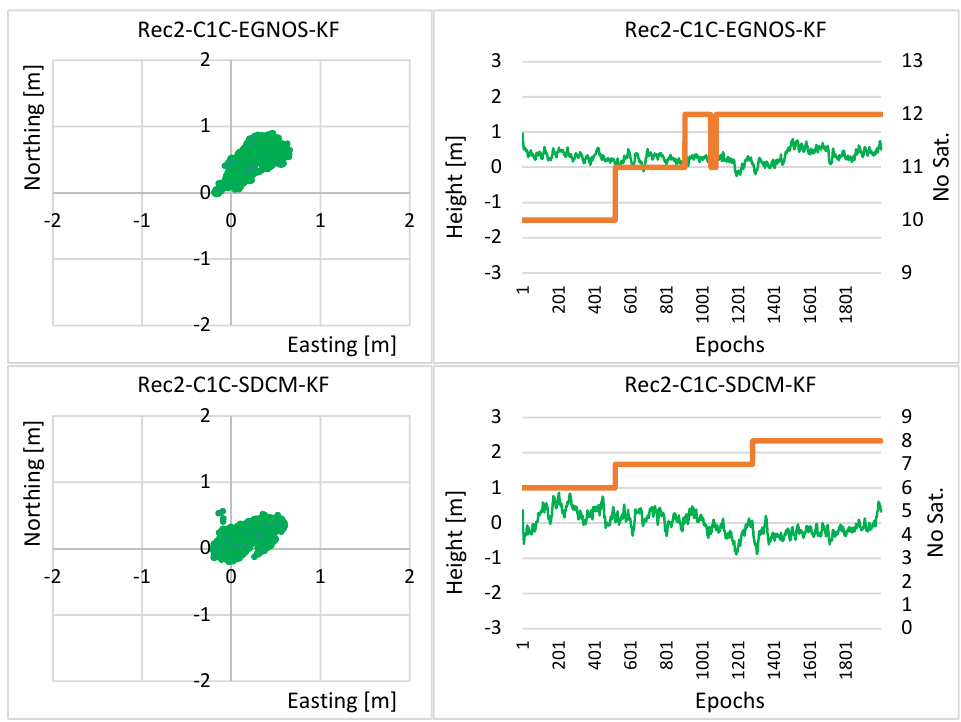
Figure 10. Real errors of horizontal and vertical coordinates of SBAS positioning based on C1C code, for the receiver Rec2 with EGNOS or SDCM corrections, with the use of Kalman filtering (Step III, see Figure 1).